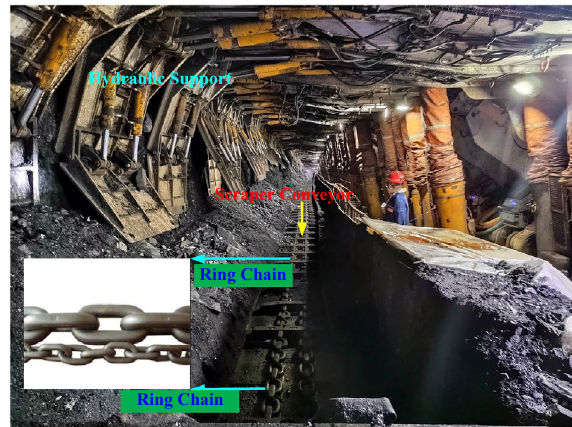
Figure 5. Actual use of underground ring chain in coal mine.